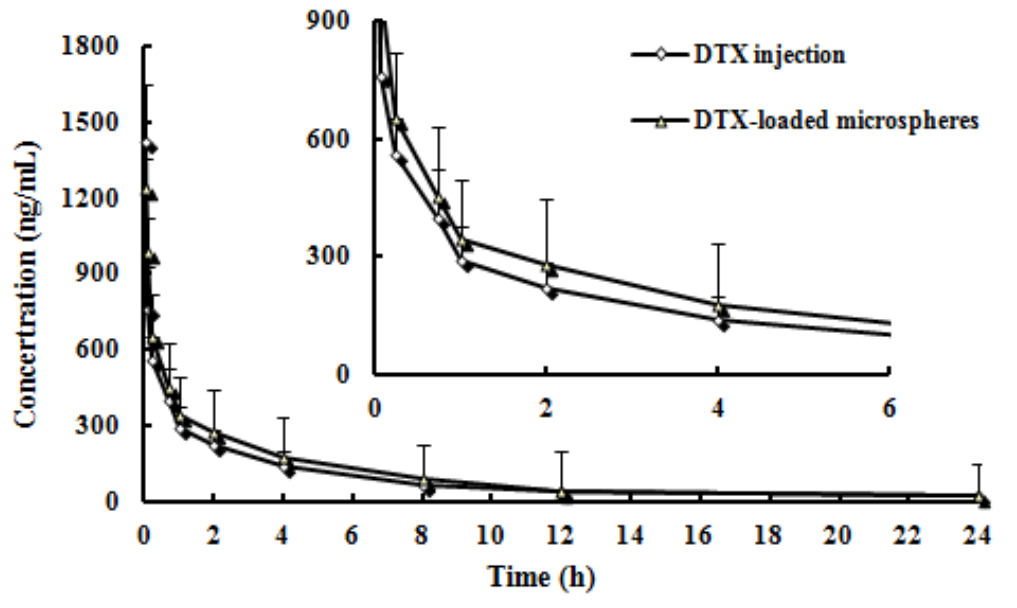
Figure 4. Mean plasma concentration-time profiles of DTX after i.v. administration of a single 5 mg/kg dose of injection and microspheres to rats (Each point represents the mean ± SD of 6 rats).